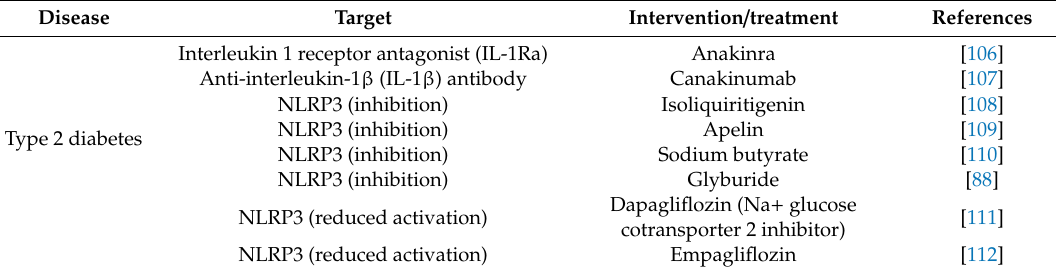
Table 1. NLRP3 antagonists in type 2 diabetes mellitus (T2D) and Alzheimer’s disease